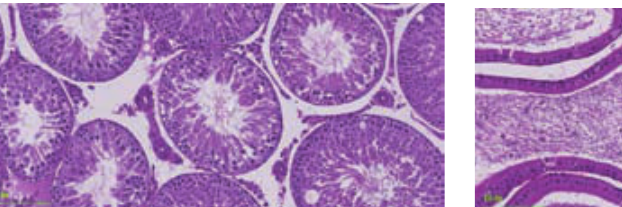
Fig 4b Low Dose -20x Cell debris in